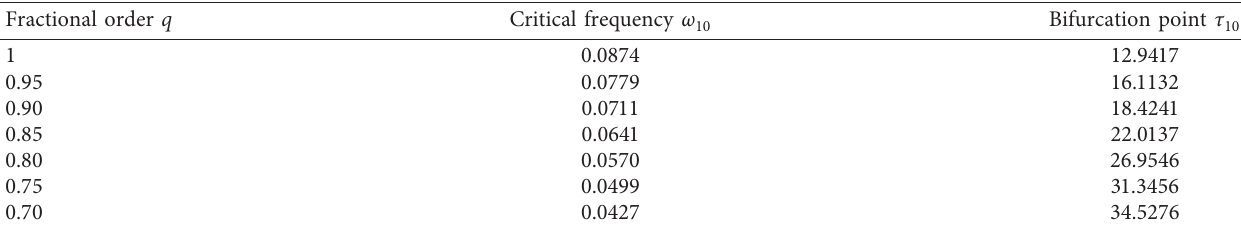
, and τ of model 10 10